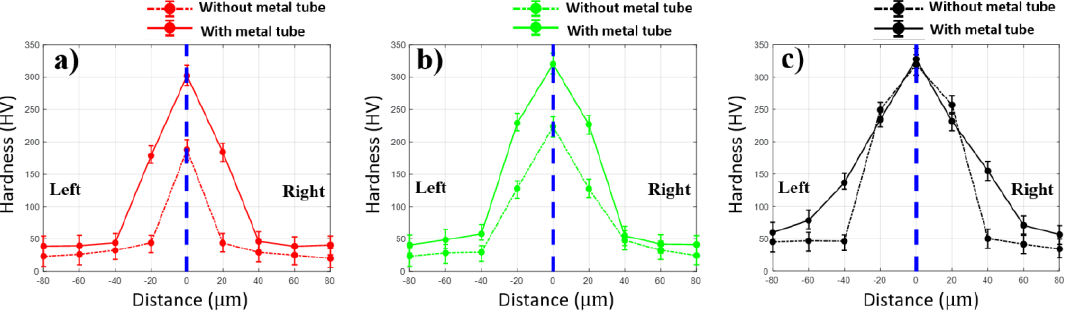
Figure 11. Hardness measurement in the horizontal direction with the laser power of ( a ) 10 W, ( b ) 15 W, and ( c ) 20W.